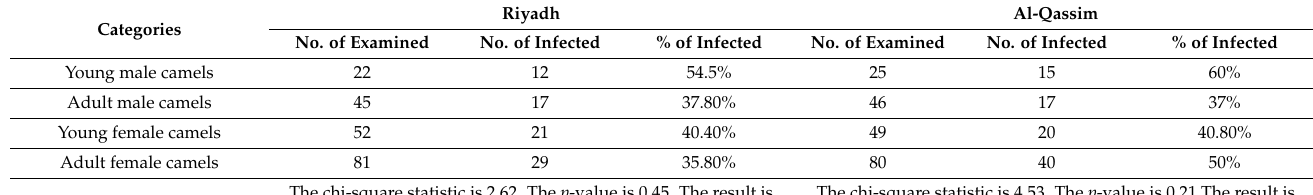
Table 3. Prevalence of T. evansi among different categories of camels.